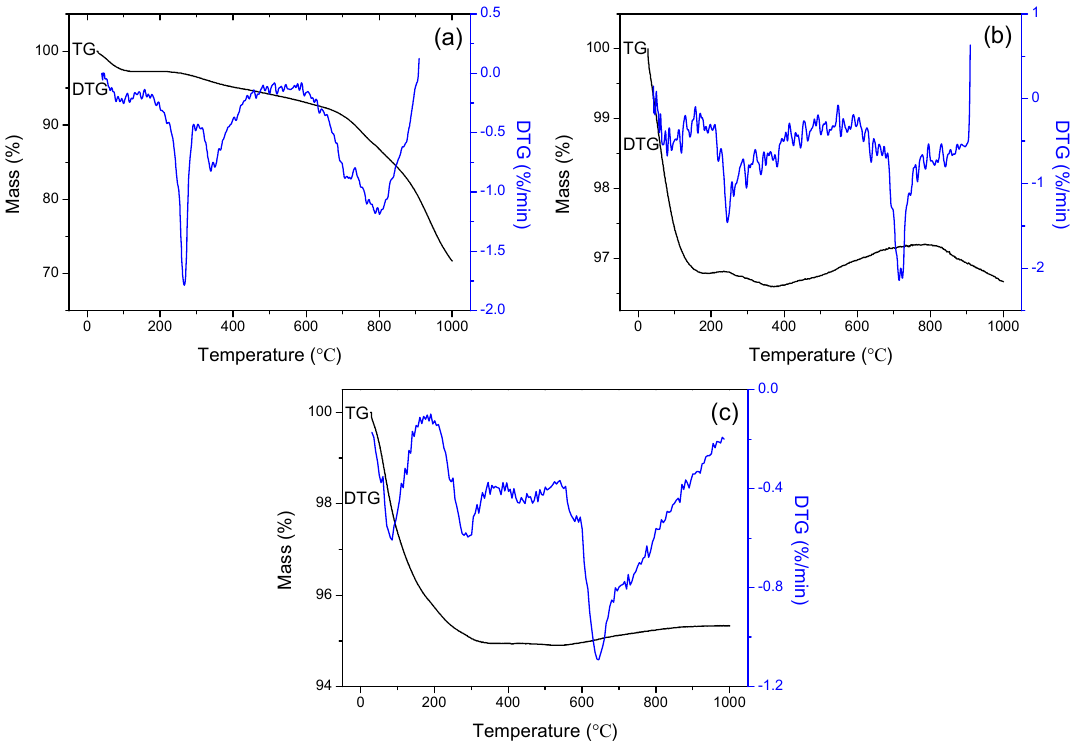
Figure 5. TGA and differential thermogravimetric analysis (DTG) curves of ( a ) Fe 3 O 4 nanoparticles, ( b ) Fe 3 O 4 /SiO 2 core-shell composite nanospheres, and ( c ) Fe 3 O 4 /SiO 2 /PPy core-shell composite nanospheres.